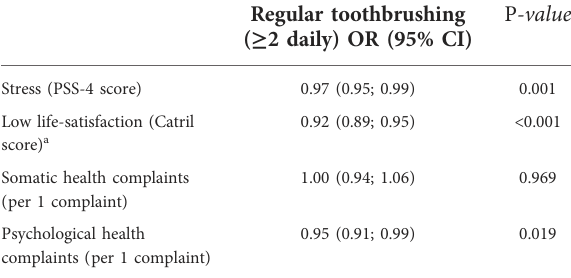
TABLE 2 Associations of mental health and well-being with regular